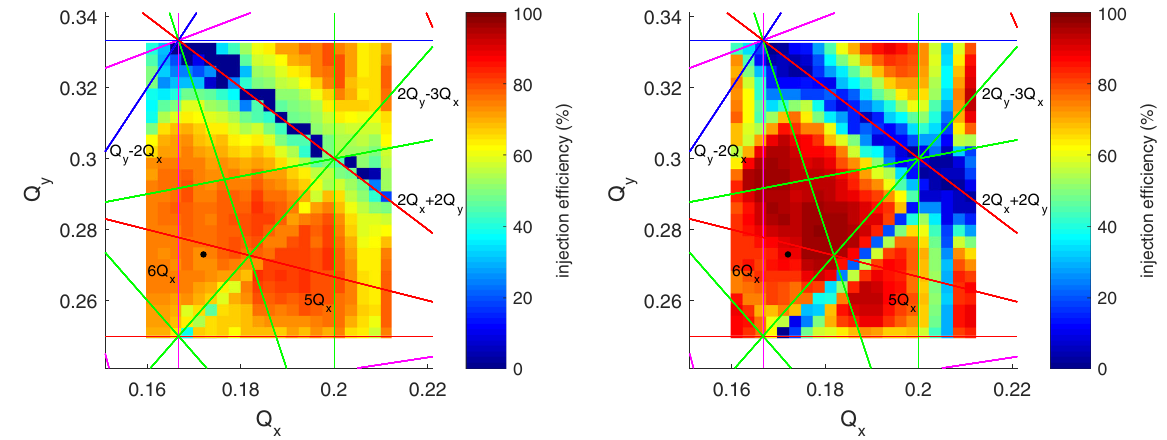
FIG. 7. Injection efficiency vs tune point measured after the installation of the DDBA cell (left) and a comparison to the predicted map found using the ELEGANT model (right).